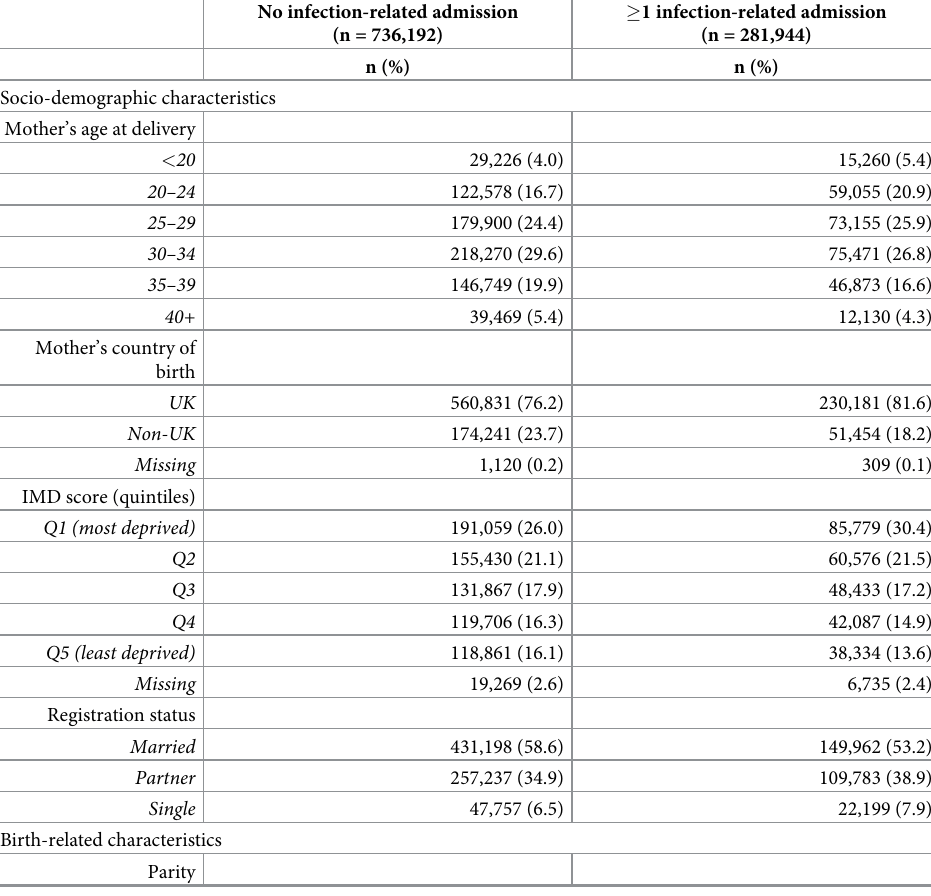
Table 1. Characteristics of sample population (n =